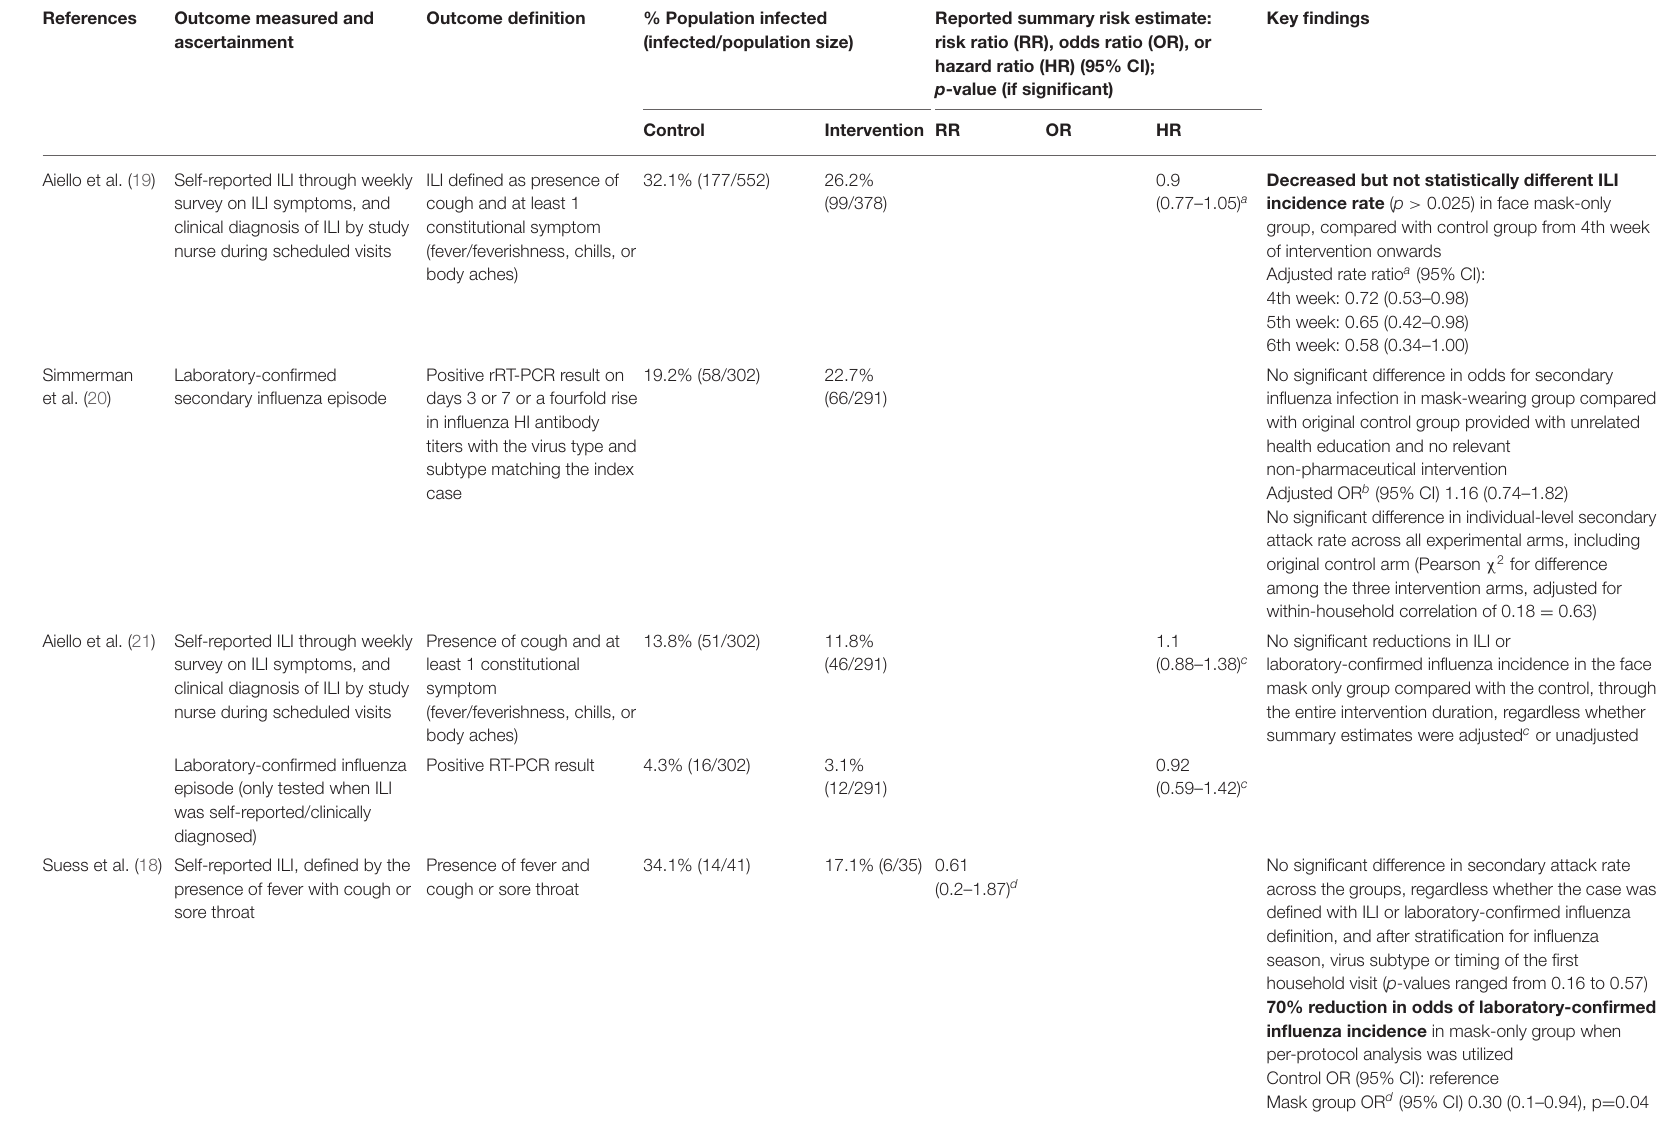
TABLE 2 | Key findings of wearing surgical face masks on ARI